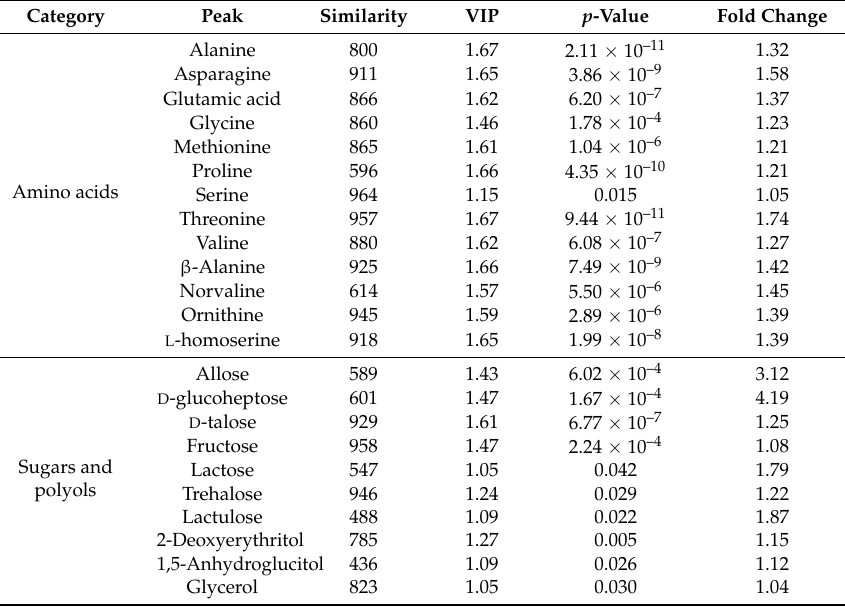
Table 5. Major metabolite changes in SRBSDV-infected WBPH under heat stress. By GC-TOF-MS analyses of six biological replicates of heat-stressed and unstressed virus-carrying WBPH, the metabolites that had a VIP > 1.0 and p -value < 0.05 were considered to be significantly altered metabolites, and amino acids, sugars, and polyols were selected to show in the